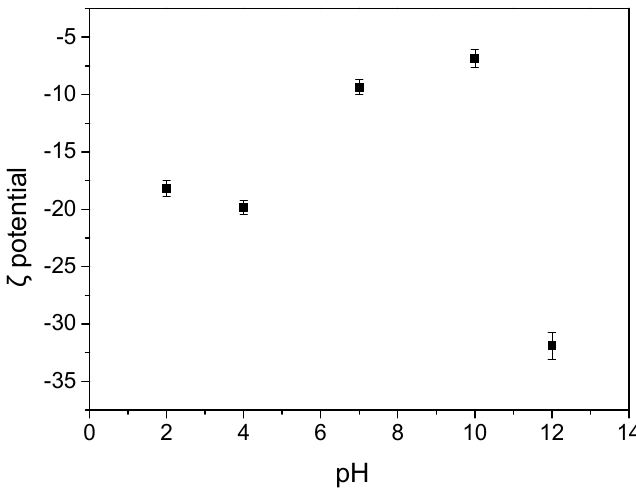
Figure 2. Zeta potential of LNO as a function of pH.